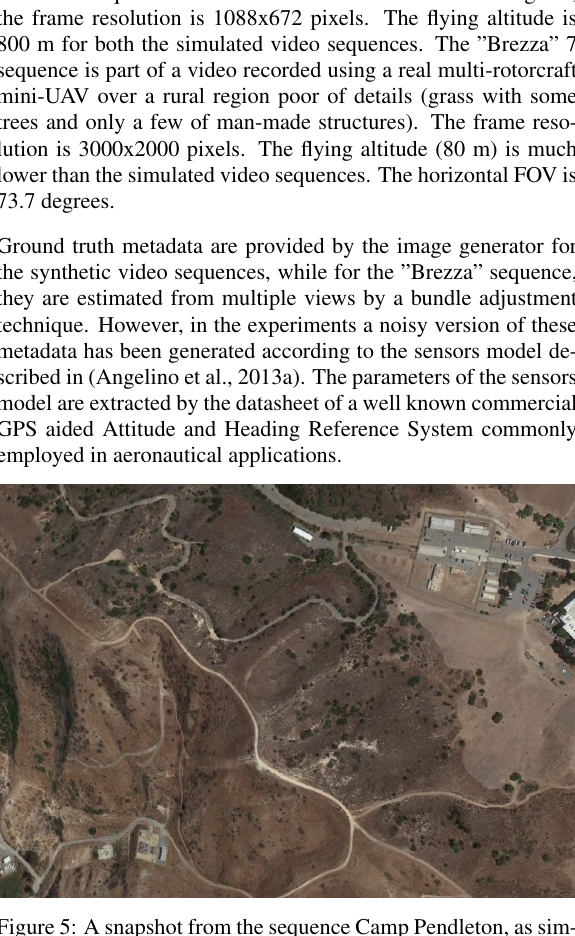
Figure 5: A snapshot from the sequence Camp Pendleton, as sim- ulated in Google Earth, with a 1088x672